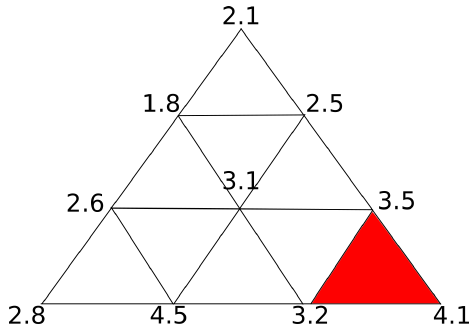
Figure 4. Highest error thresholding example in a surface mesh where each vertex has an error associated and area threshold is set to triangle size. Highlighted in red is the triangle with the highest error with 3.2 σ